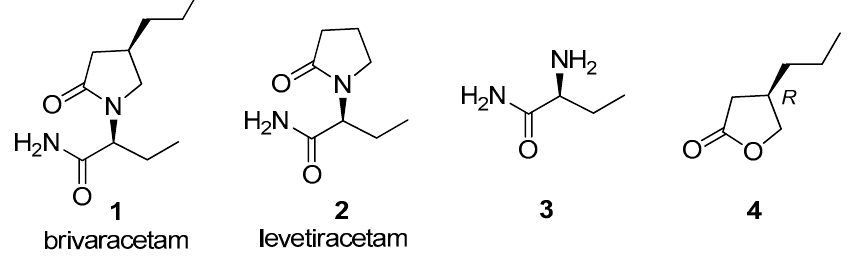
Figure 1. Structures of brivaracetam and related compounds.